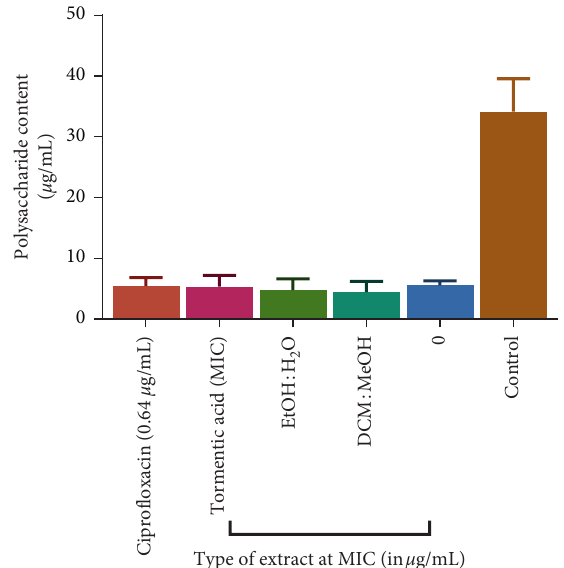
Figure 9: The effect of ciprofloxacin, tormentic acid congener, and C. viminalis extracts on extracellular polysaccharide content in S. pyogenes . Quantification of extracellular polysaccharide content of S. pyogenes was performed using the 5% phenol saturated sulphuring acid test and collection and measuring of the super- natant. All test agents inhibited the formation of capsular exo- polysaccharides in S. pyogenes